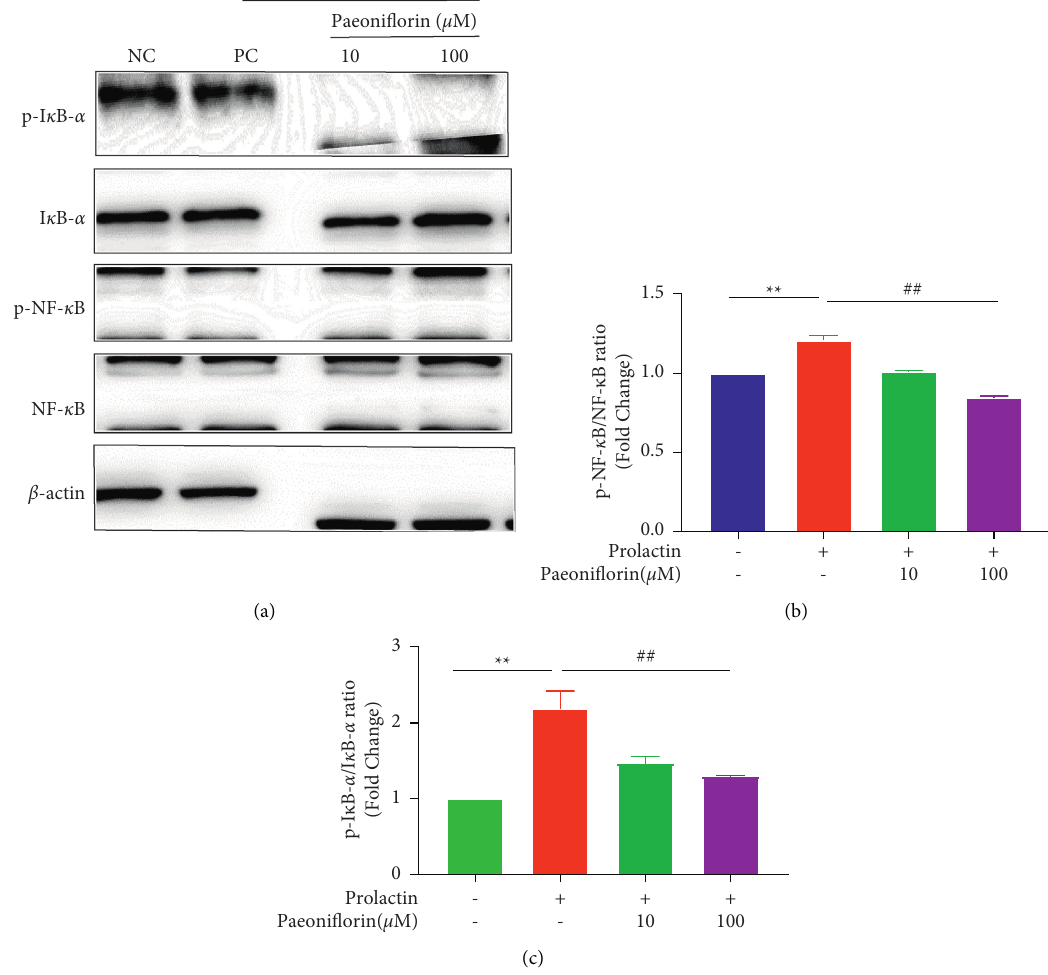
Figure 6: Paeoniflorin suppressed HPRL-induced NF- κ B signaling pathway activation during osteoblastogenesis. (a) Cell lysates were subjected to WB analysis with antibodies against phospho-I κ B- α , I κ B- α , phospho-NF- κ B, and NF- κ B. (b and c) The ratios of p-I κ B- α /I κ B- α and p-NF- κ B/NF- κ B. n � 3, ∗∗ P < 0 . 01, ∗ vs the NC group; ## P < 0 . 01, # vs the PC